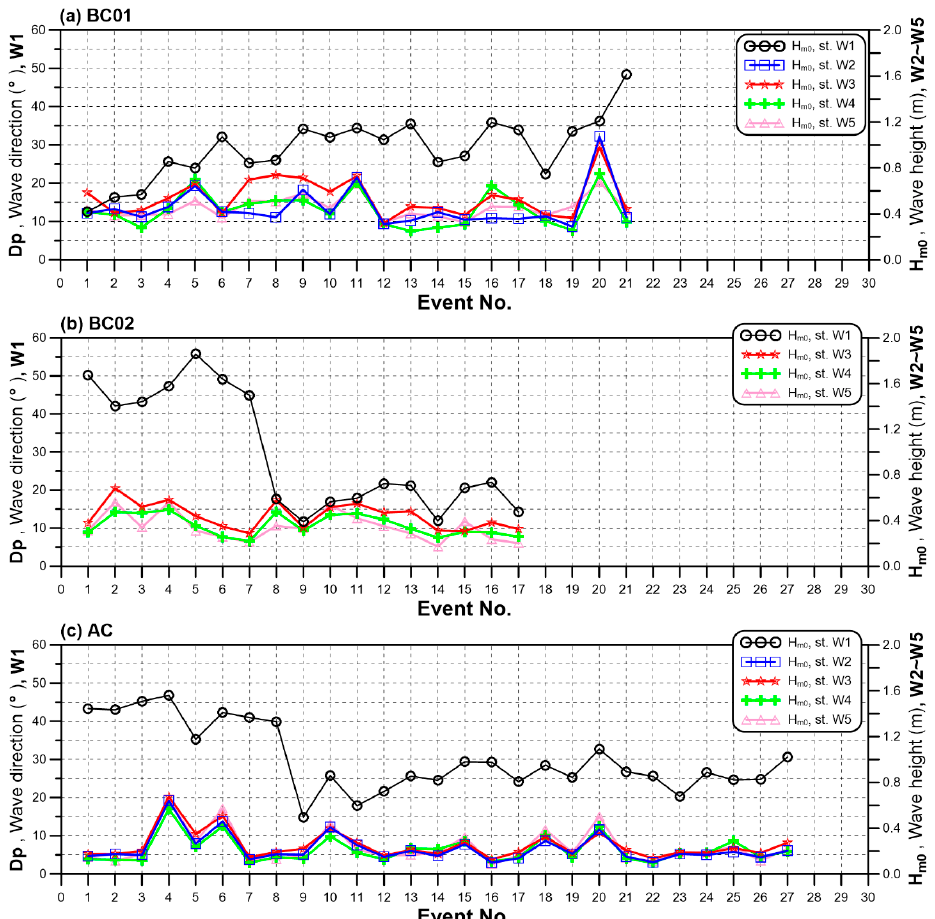
Figure 5. ( a ) Maximum values of 𝐻 (cid:3040)(cid:2868) observed in the 21 events before construction in W1 (black circles), W2 (blue squares), W3 (red stars), W4 (green crosses), and W5 (pink triangles) for BC01 (15 October 2008~12 July 2009); ( b ) maximum 𝐻 (cid:3040)(cid:2868) values for the 17 events before construction in W1 (black circles), W3 (red stars), W4 (green crosses), and W5 (pink triangles) for BC02 (21 May 2018~13 February 2019) (it is noted that the 𝐻 (cid:3040)(cid:2868) in W2 was not included due to poor data quality); ( c ) max- imum 𝐻 (cid:3040)(cid:2868) values for the 27 events after the construction in W1 (black circles), W2 (blue squares), W3 (red stars), W4 (green crosses), and W5 (pink triangles). The pattern of 𝐻 (cid:3040)(cid:2868) variation is similar between the wave stations outside (W1) and inside (W2, W3, W3, and W4) the port.